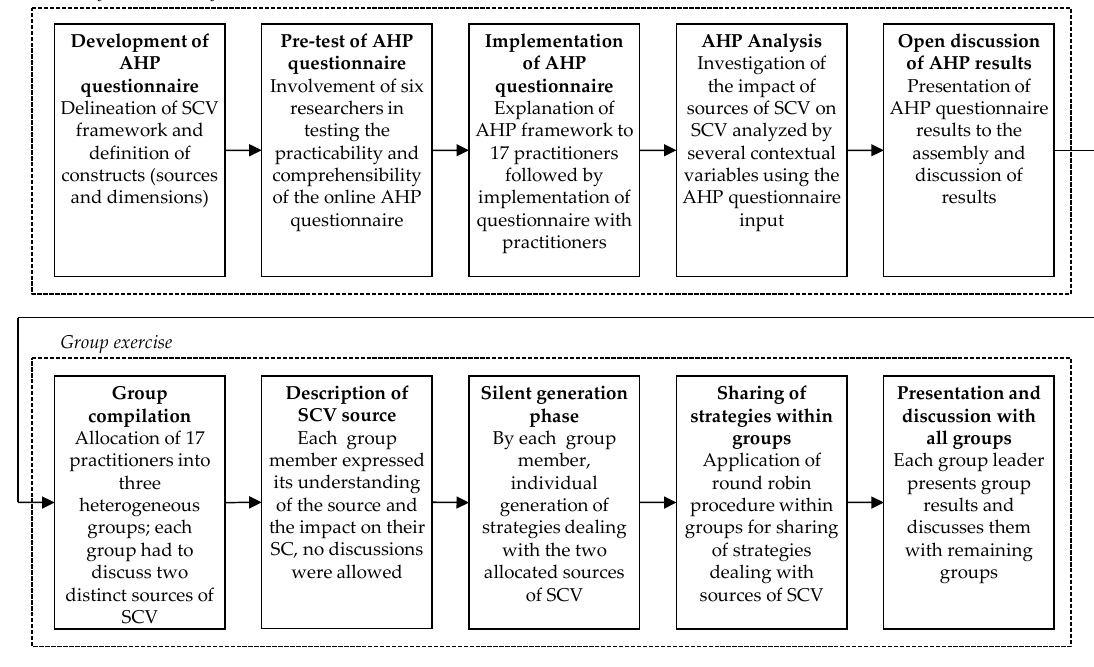
Figure 2. Research procedure. Table 2. Sample demographics of participants in on ‐ site workshop.